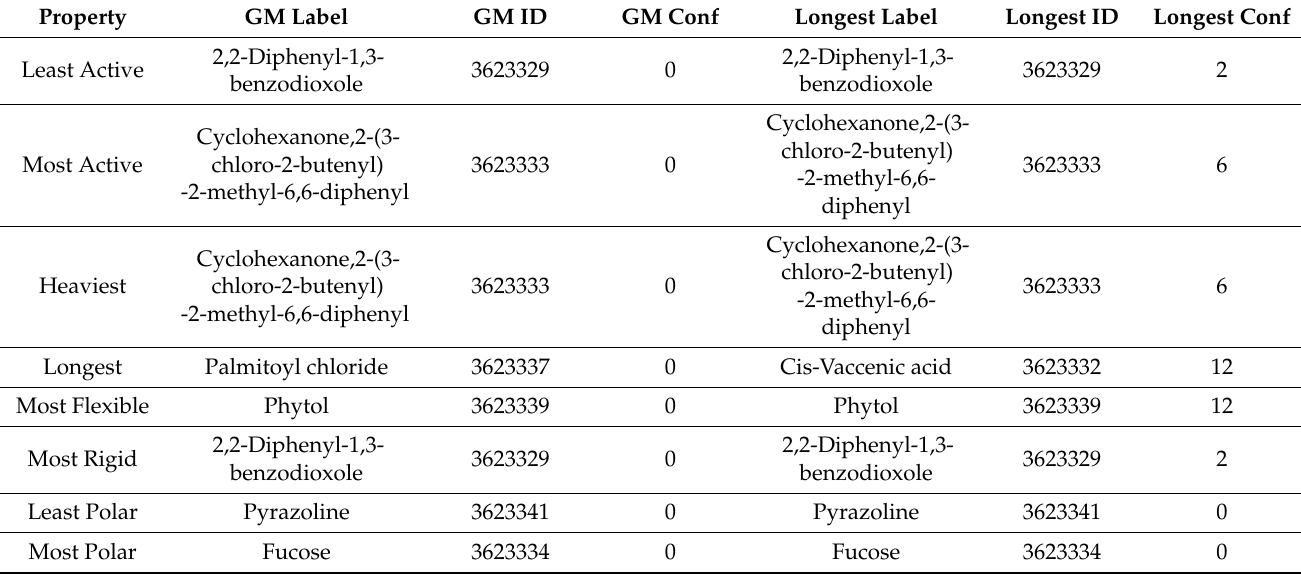
Table 7. Biological activity and conformer of